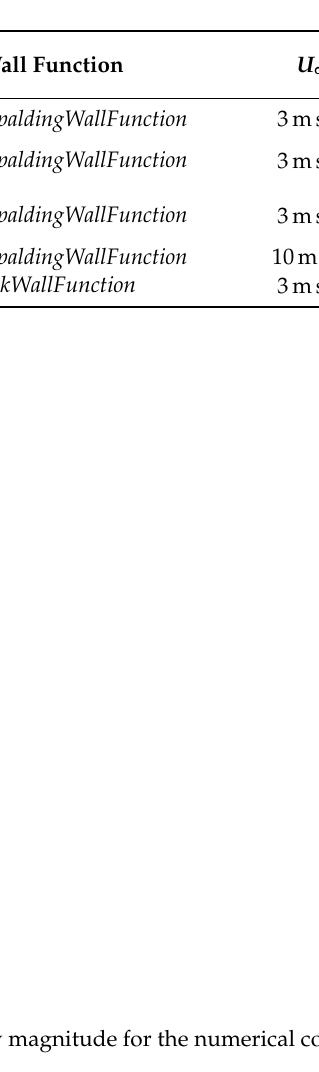
Table A3. Summary of the sensitivity tests for the AR=1 canyon. For R-wall, OpenFOAM’s nutkWall- Function is used.